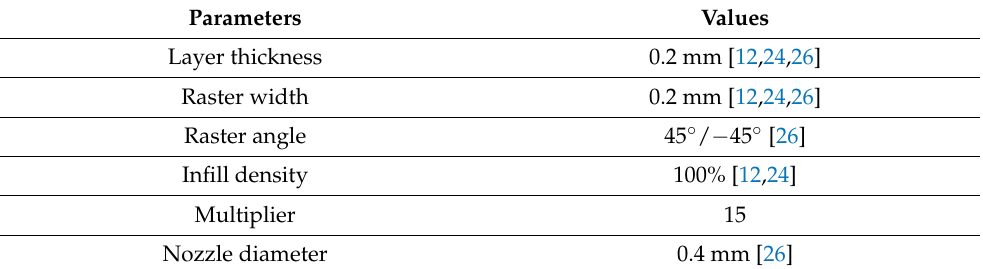
Table 3. Parameters for screw extrusion 3d printing.